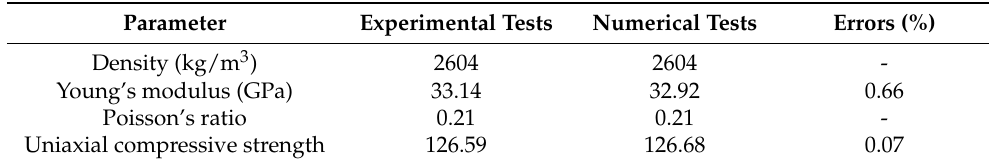
Figure 1. Comparison of experimental and numerical stress–strain curves and failure modes for standard cylindrical granite specimens under uniaxial compression. Experimental and numerical macro-mechanical properties of standard cylindrical granite